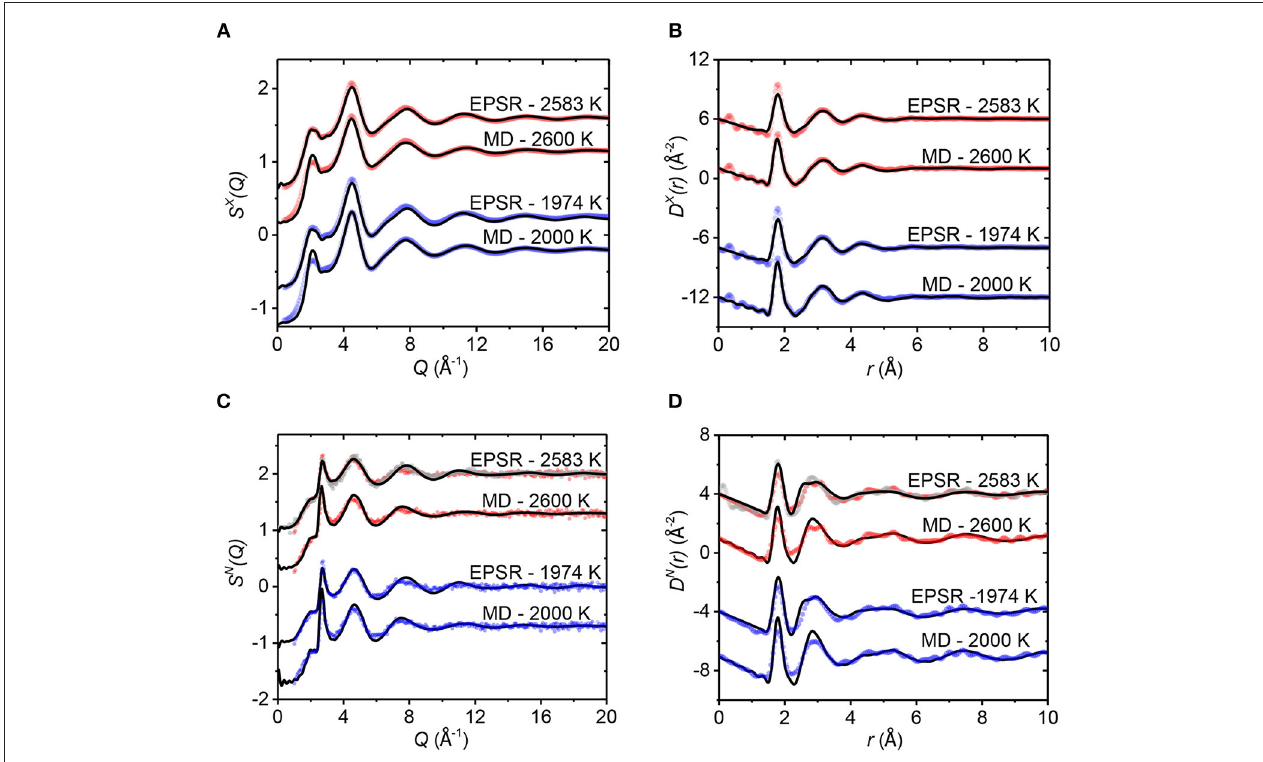
FIGURE 2 | The x-ray (A,B) and neutron (C,D) total structure factors S(Q) (A,C) and total distribution functions D(r) (B,D) , obtained with a Q max of 20.0 Å − 1 . In each panel, the measured data (points) are compared to the EPSR and MD simulation results (solid black lines). Skinner et al. (2013) neutron data are plotted as gray circles for comparison. Vertical offsets have been applied for